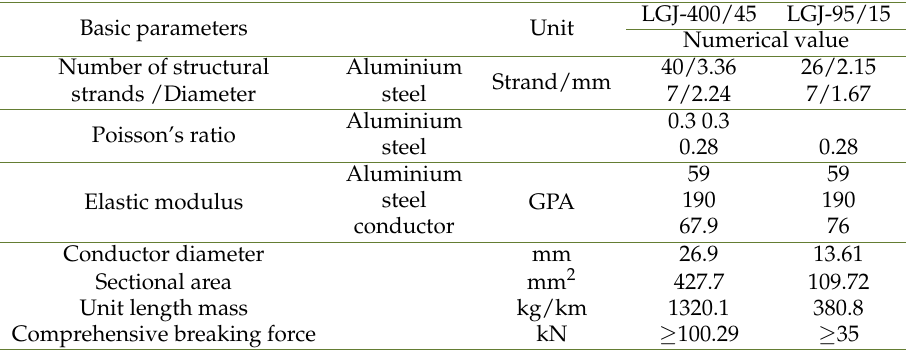
Table 4. Material and geometric parameters of LGJ-400/45 and LGJ-95/15 conductors